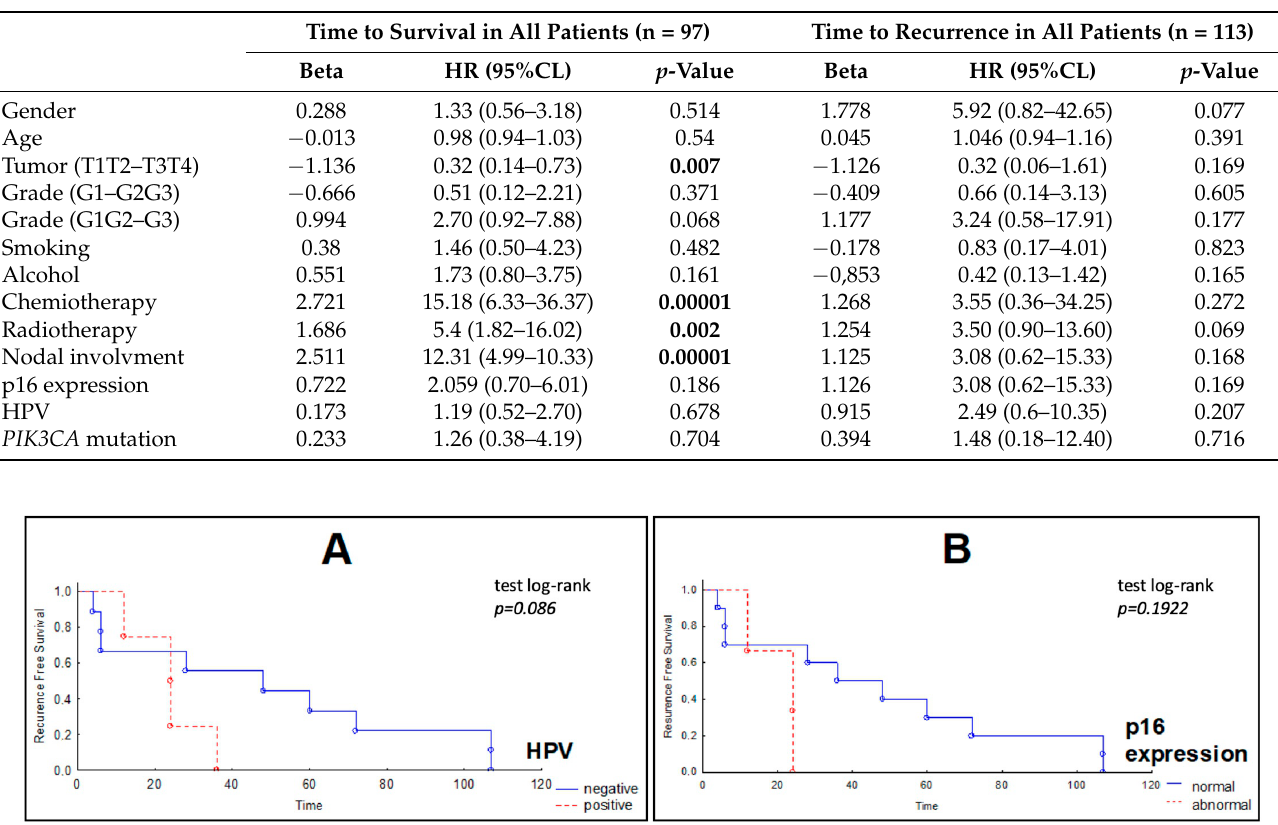
Table 3. Univariate Cox regression analysis of potential predictor variables ( p < 0.05 was bolded; abbreviations: HR— hazard ratio, CI—confidence intervals, HPV—human papilloma virus).